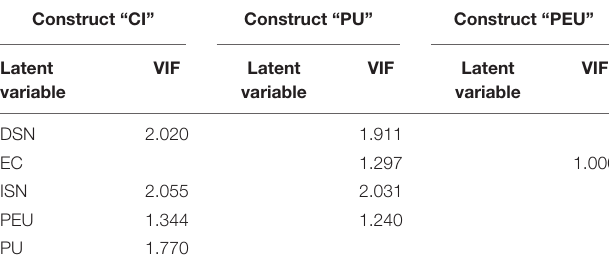
TABLE 3 | Results for reliability and validity.